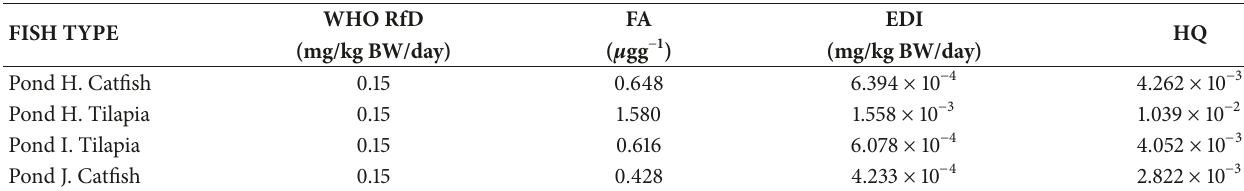
Table 7: The EDI results for carcinogenic risk evaluation expressed in mg/kg body weight/day for tilapia and catfish from fish ponds (H, I and